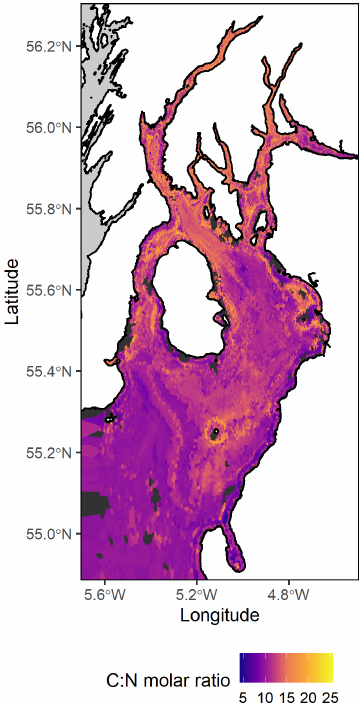
Figure 16. Variation in the predicted organic carbon–nitrogen mo- lar